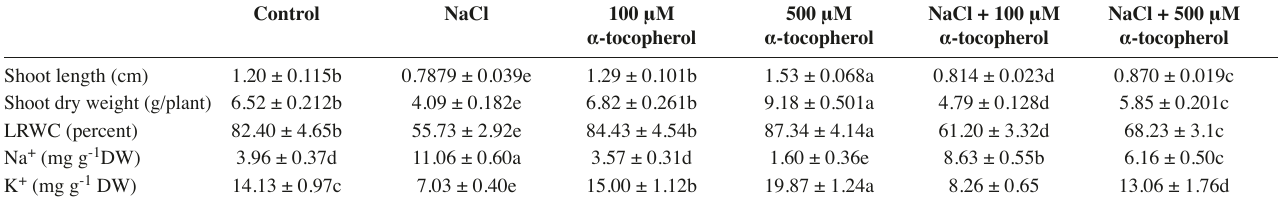
Tab. 1: Effect of salinity (100 mM NaCl) with and without exogenous application of α -tocopherol (100 and 500 μM) on shoot length (cm), shoot dry weight (g/ plant), leaf relative water content (LRWC), sodium and potassium (mg g -1 DW; DW = dry weight) content in soybean ( Glycine max ). Values are mean (±SE) of five replicates and different letters represent significant difference at p<0.05.